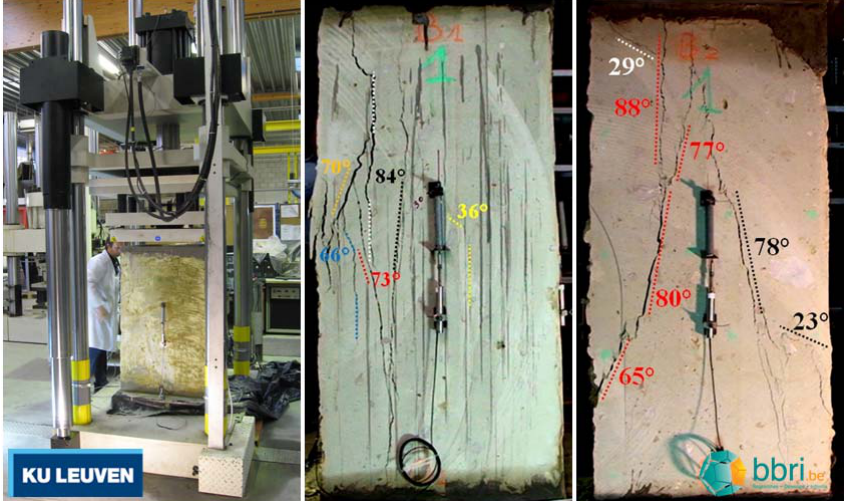
Figure 4. Large ‐ scale UCS test performed on real ‐ scale soil mix element within the framework of the BBRI Soil Mix project (2009 ‐ 2013) [23,